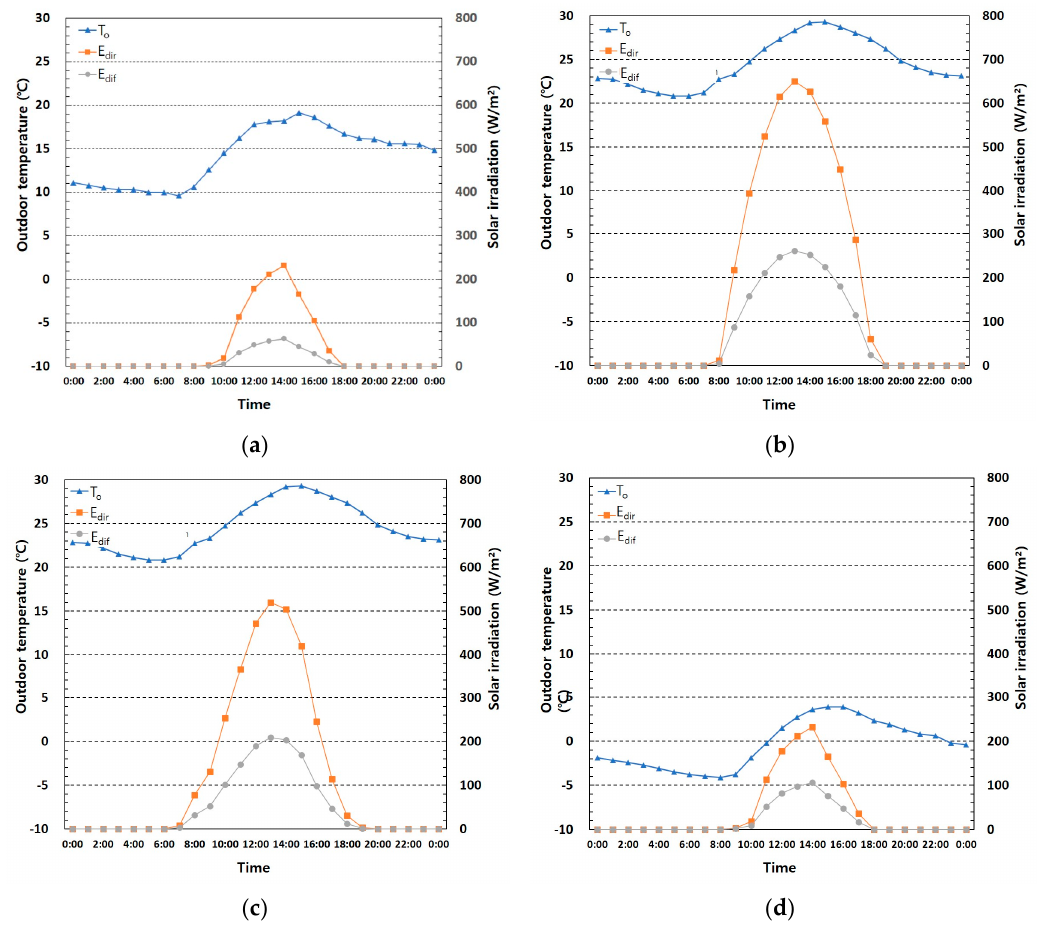
Figure 5. Four different weather conditions of Seoul: ( a ) cloudy sky and moderate temperature (intermediate season); ( b ) clear sky and hot temperature (summer season); ( c ) cloudy sky and hot temperature (summer season); ( d ) cloudy sky and cold temperature (winter season).